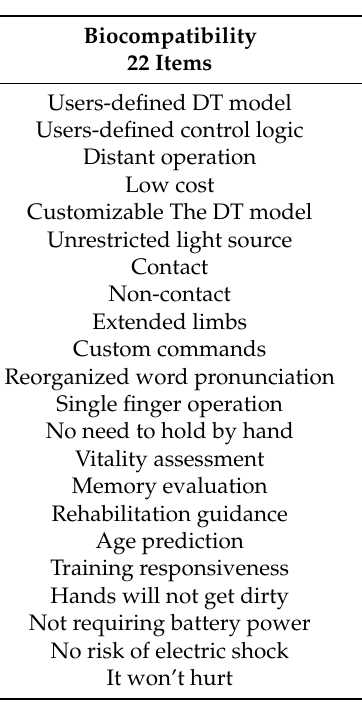
Table 5. Comparison of Three Types of DTs’